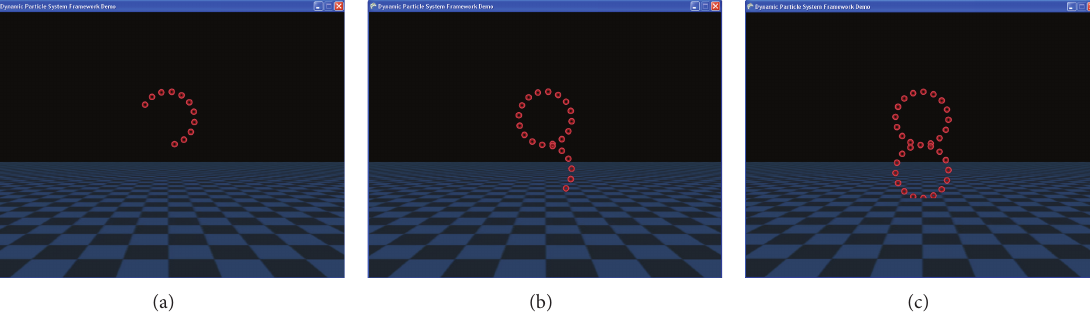
Figure 4: Particles traveling in a figure-eight pattern.